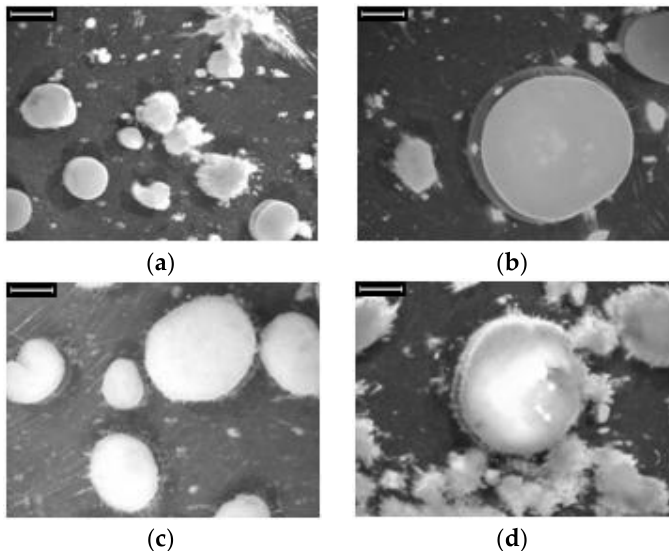
Figure 1. Images of biomass at different operational days: ( a ) SBR I (10 days); ( b ) SBR I (18 days); ( c ) SBR II (9 days); ( d ) SBR II (18 days). The bar represents 2 mm.